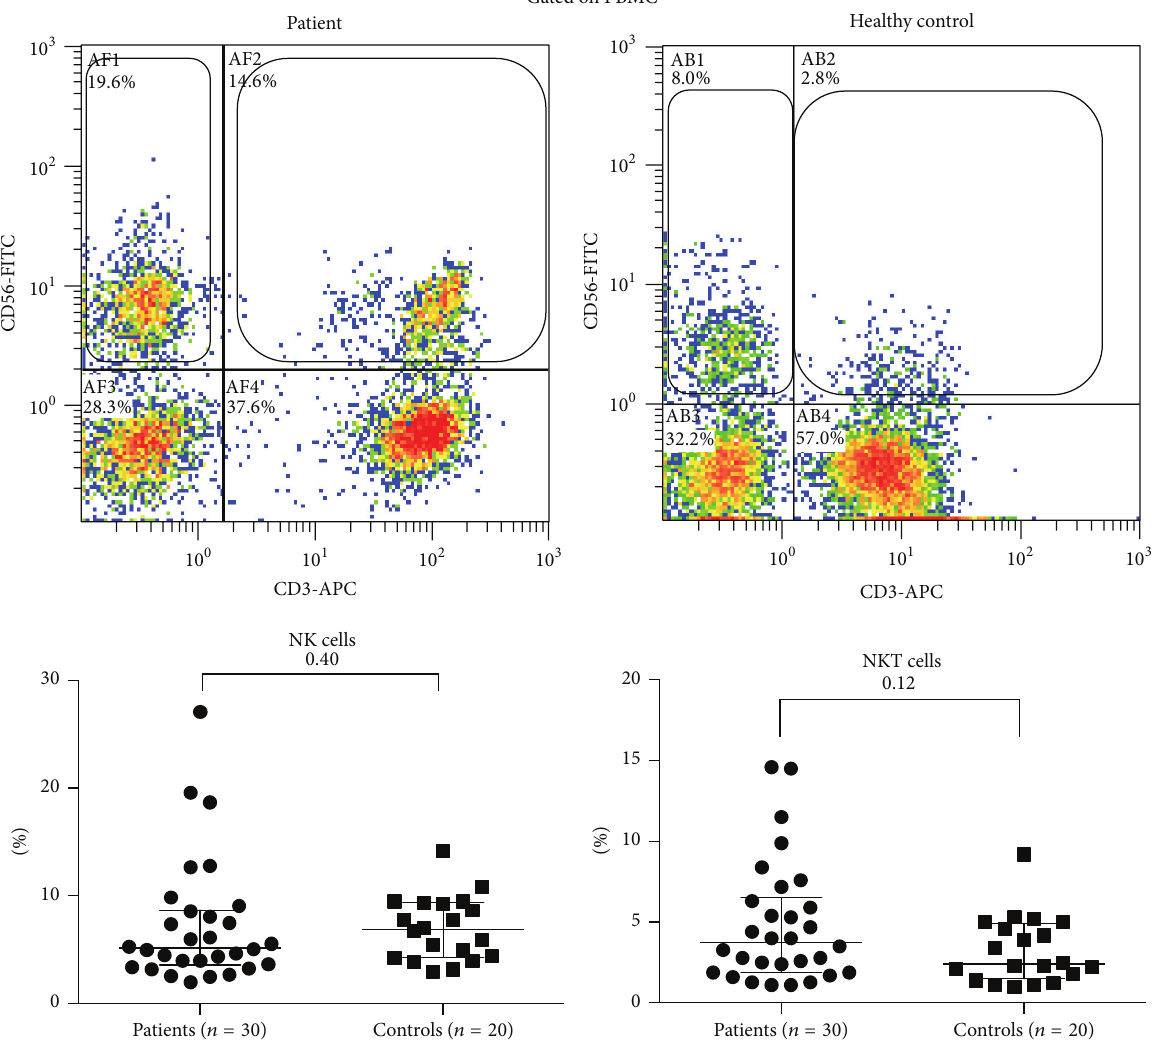
Figure 1: In peripheral blood of 30 patients and 20 controls, natural killer (NK) and natural killer T (NKT) cells were identified by gating on PBMCs and surface staining for CD3 and CD56. NK cells were CD3 − CD56 + and NKT cells were CD3 + CD56 + . Bars represent median with interquartile range. 𝑝 value (Mann-Whitney test) is mentioned in each